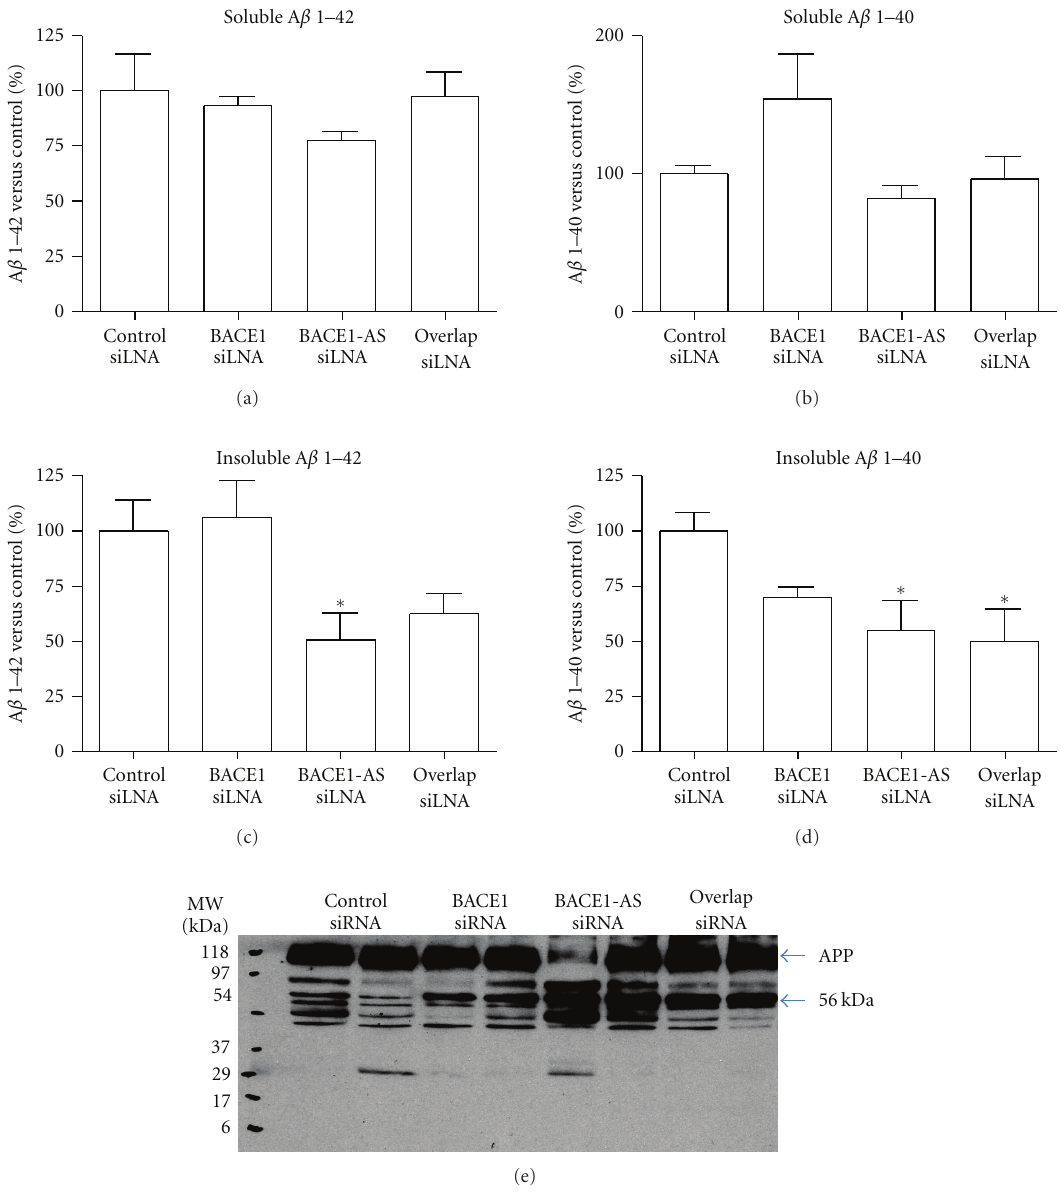
Figure 6: E ff ects of siLNA in for BACE1, BACE1-AS and overlap region in A β formation and aggregation. The infusion of siLNA for two weeks did not change the total amount of soluble A β in hippocampus (a), however, it did change the aggregation pattern (b). The measurement of insoluble A β (plaque aggregates) by guanidine extraction showed a significant decrease with BACE1-AS treatment (c-d).